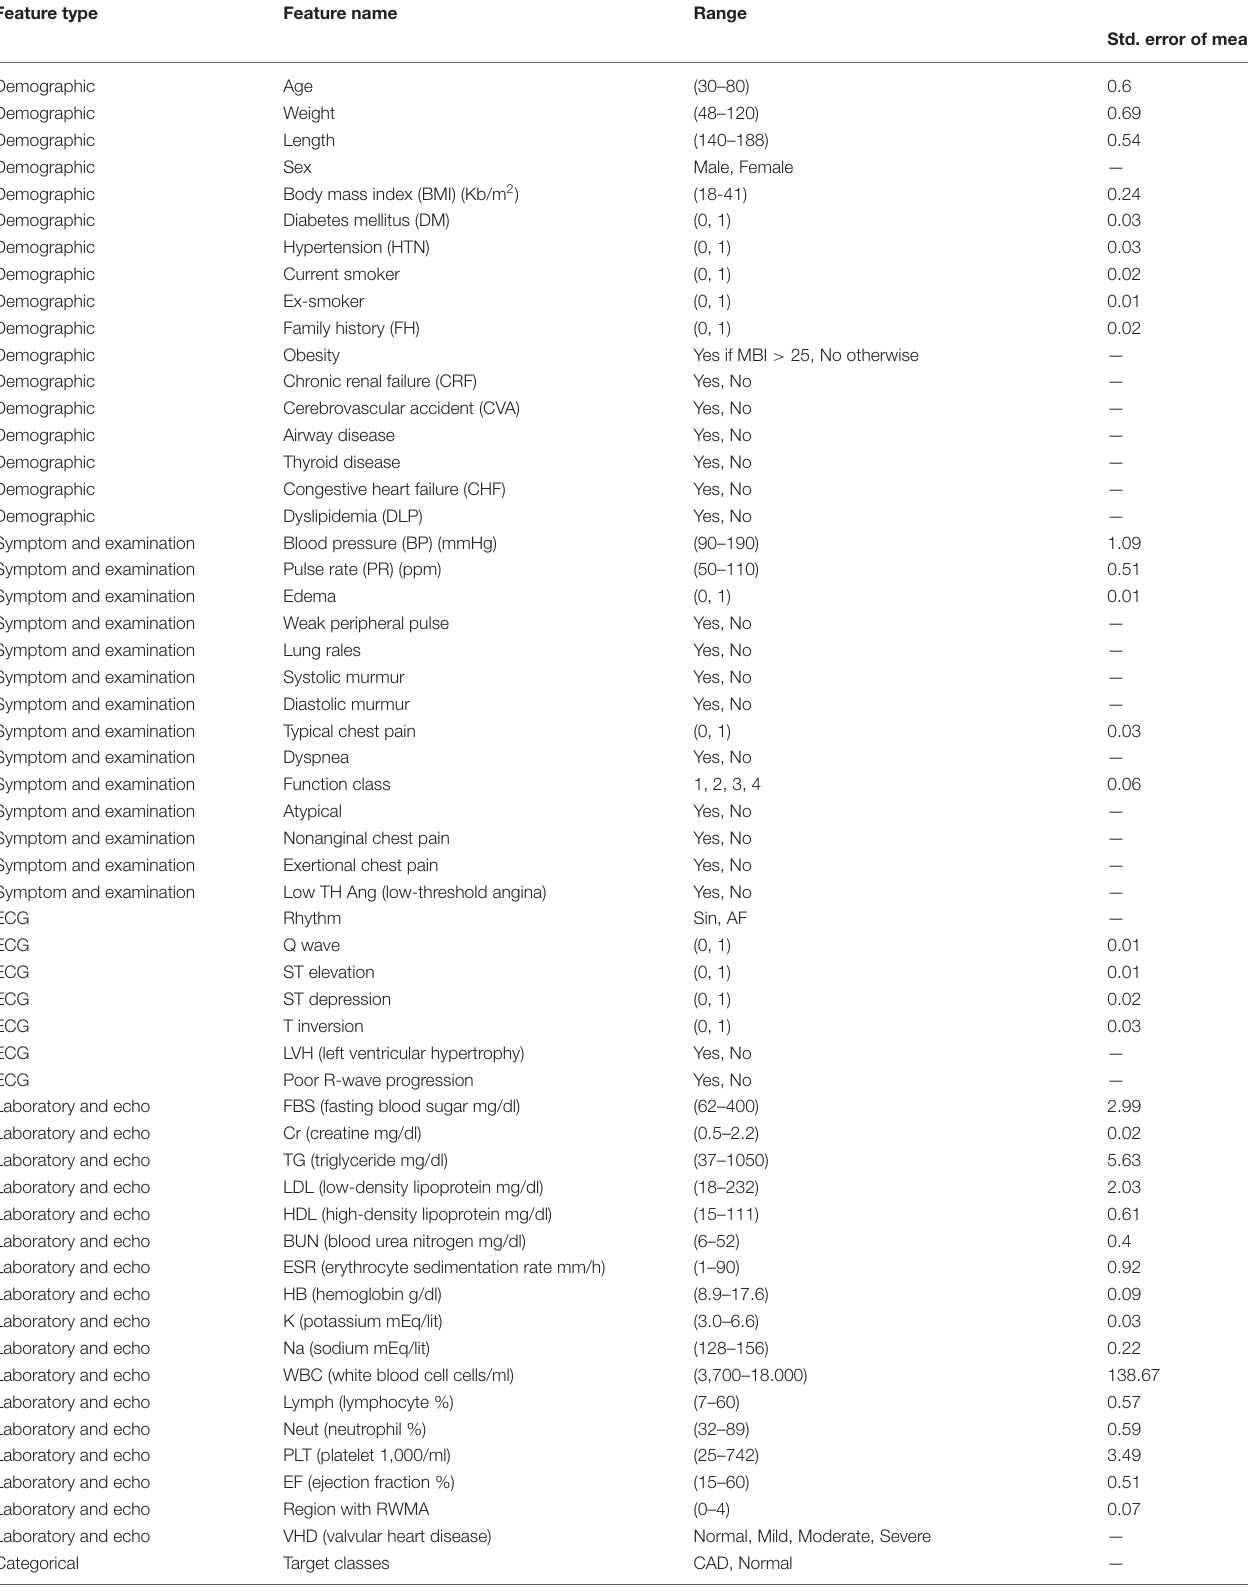
TABLE 1 | Description of the Z-Alizadeh-Sani dataset